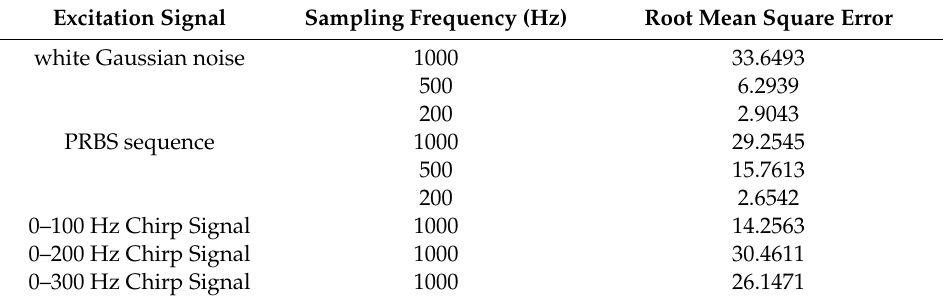
Table 2. Results of di ff erent identification system.